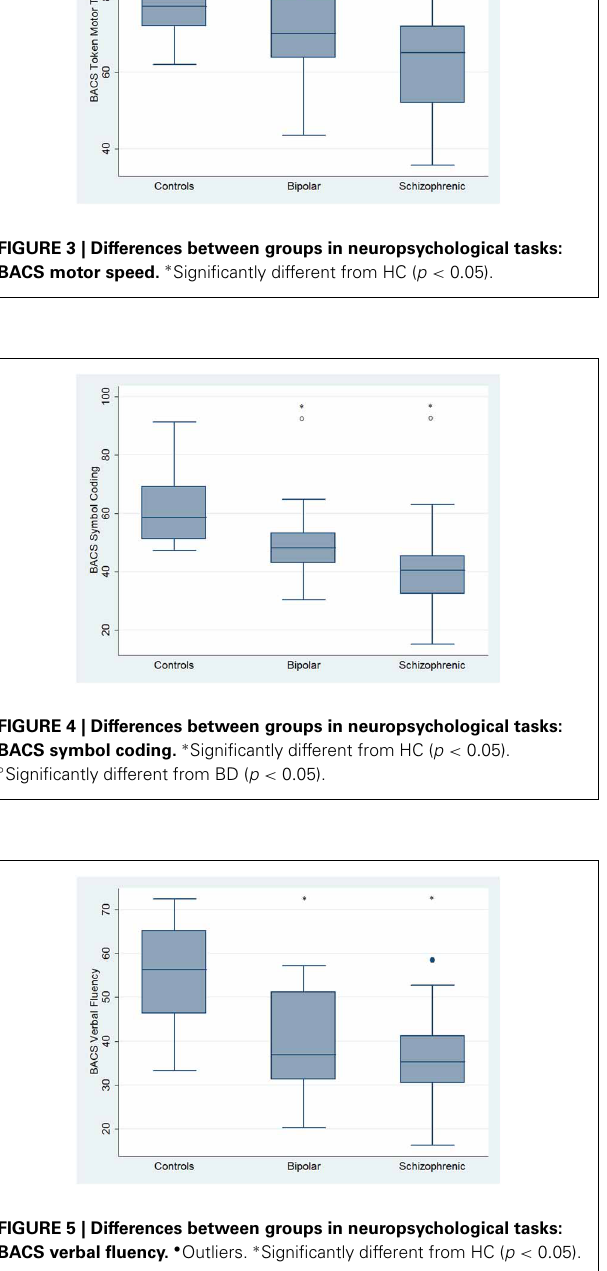
SKZ: z = − 3 . 819, p = 0 . 0001) ( Figure 8 ), broke more rules (for BD: z = − 4 . 916, p < 0 . 001; for SKZ: z = − 3 . 893, p = 0 . 0001)